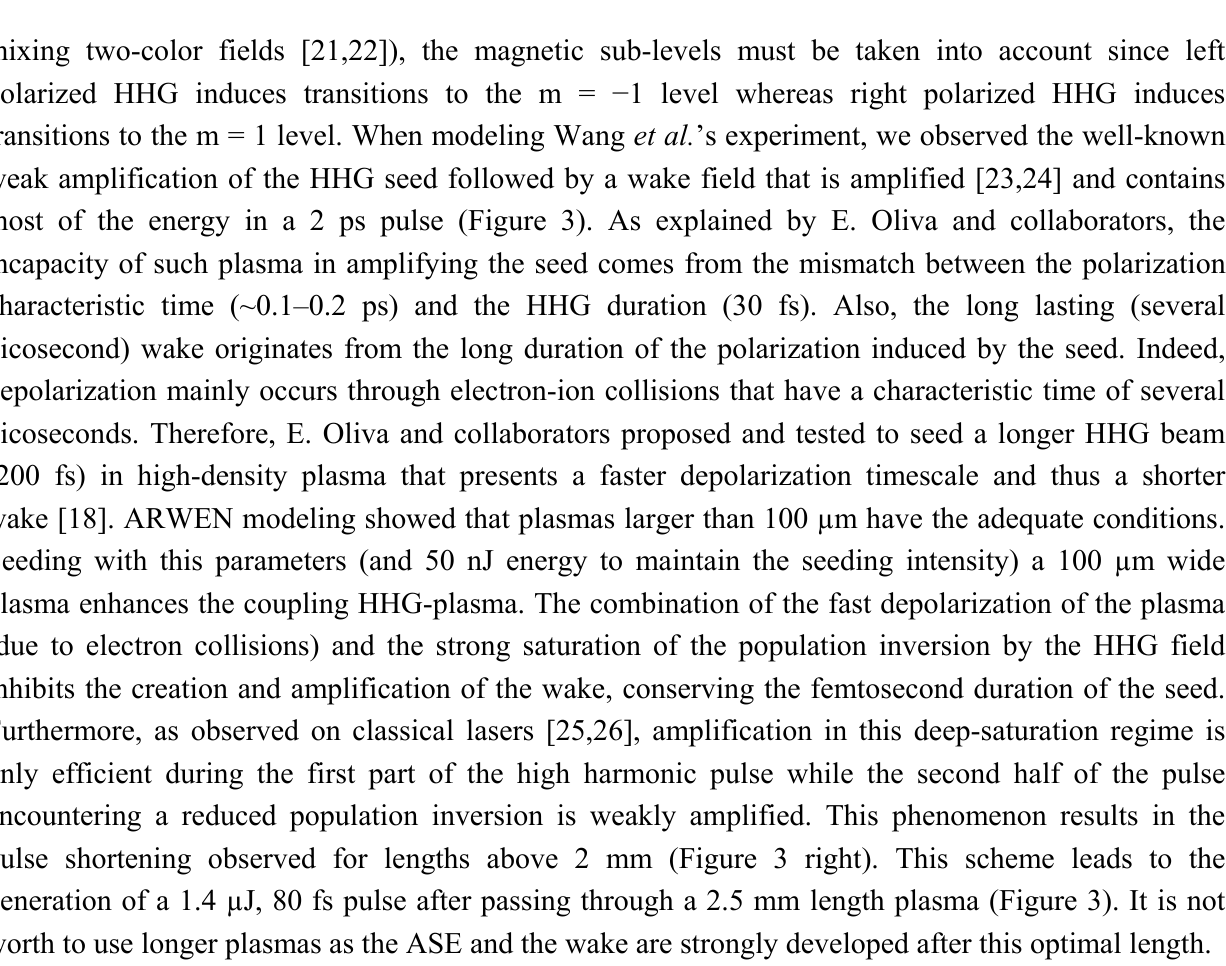
Figure 3. Evolution of the intensity versus time along the 30 µm ( left , high harmonic generation (HHG) = 30 fs) and 100 µm width ( right , HHG = 200 fs) plasma columns. The green, red and blue lines stand for the ASE, seed and wake fields. The vertical scales are not constant to account for